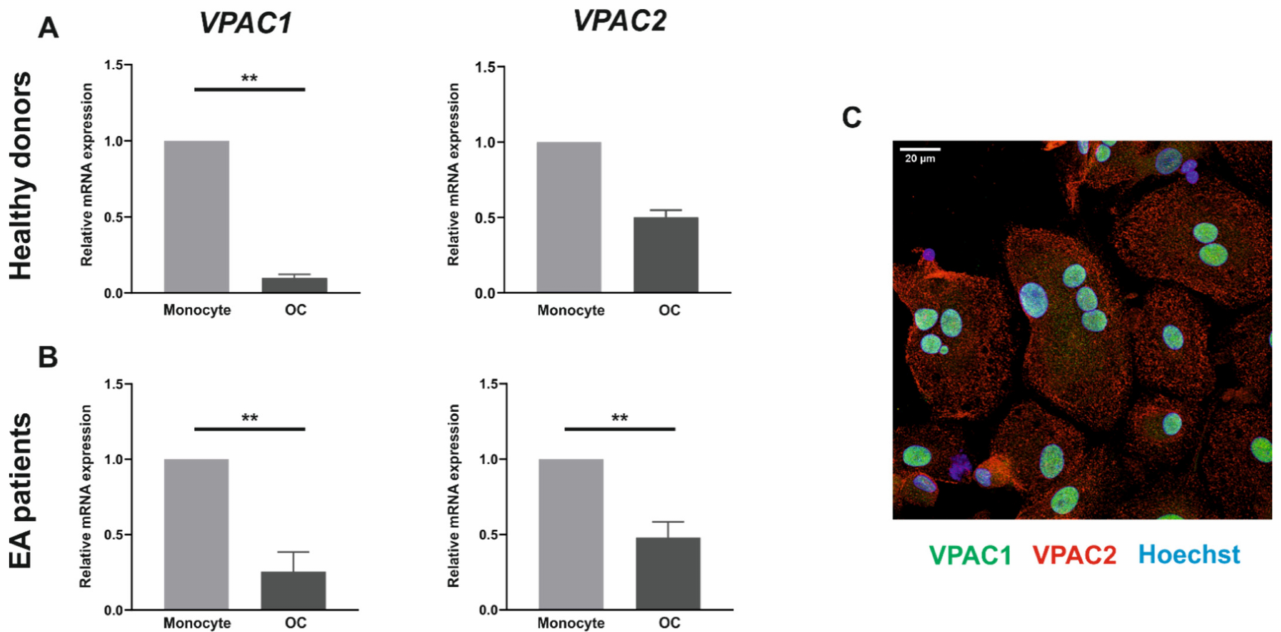
Figure 1. VPAC1 and VPAC2 expression in monocytes and in vitro differentiated osteoclasts. VPAC1 and VPAC2 mRNA expression levels in monocytes and in differentiated osteoclasts (OC) from 5 healthy donors ( A ) and 5 early arthritis patients ( B ) was determined by real-time PCR. Results are expressed as relative mRNA expression (relative to GAPDH levels). The means ± SEM of triplicate determinations are shown. Mann–Whitney U test was performed (** p < 0.01). ( C ) Immunofluorescence analysis on in vitro differentiated osteoclasts from healthy donors using specific antibodies for VPAC1 (Alexa Fluor 488, green) and VPAC2 (Alexa Fluor 594, red). Nuclei were counterstained with Hoechst (blue). Florescence was examined on a Leica SP8 LIGHTNING confocal